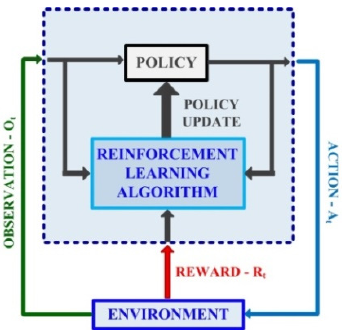
Figure 3. The schematic diagram for an RL of process control.